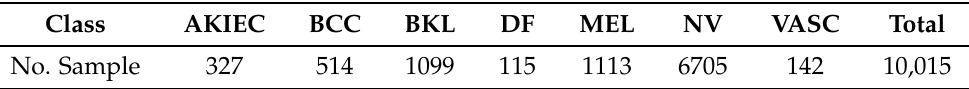
Table 2. Data distribution in HAM10000.